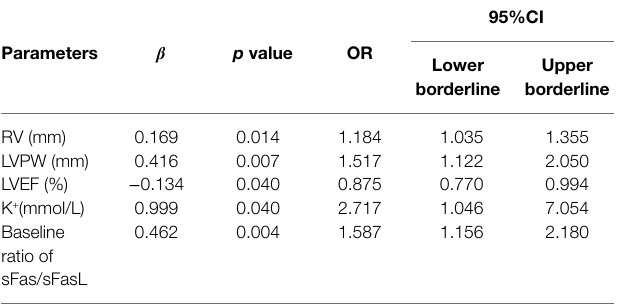
TABLE 4 | Adjusted logistic regressions for PH.